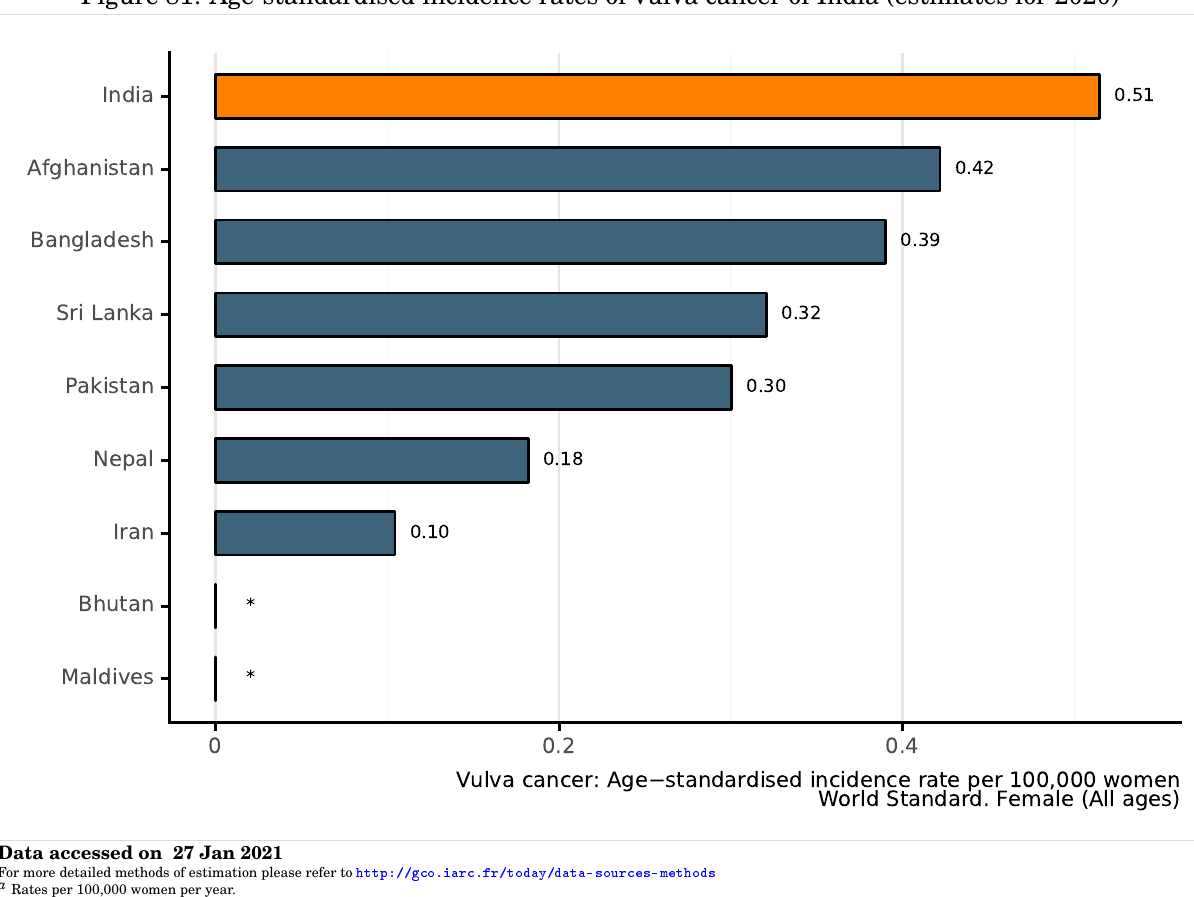
Figure 81: Age-standardised incidence rates of vulva cancer of India (estimates for 2020)